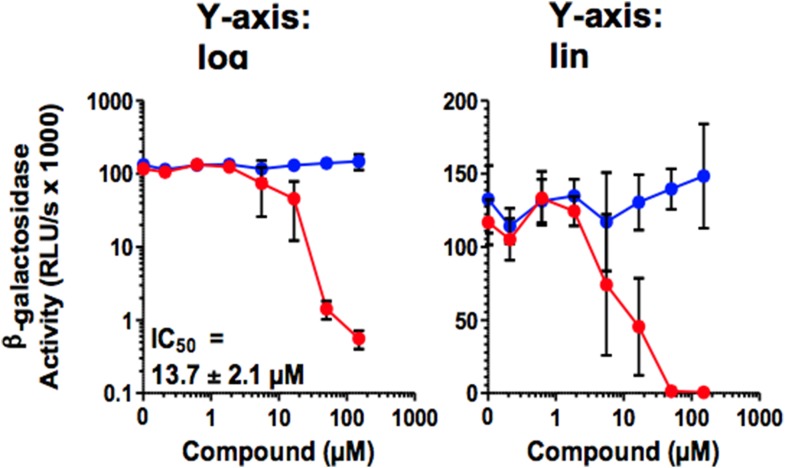
DOI:
http://dx.doi.org/10.7554/eLife.05397.032